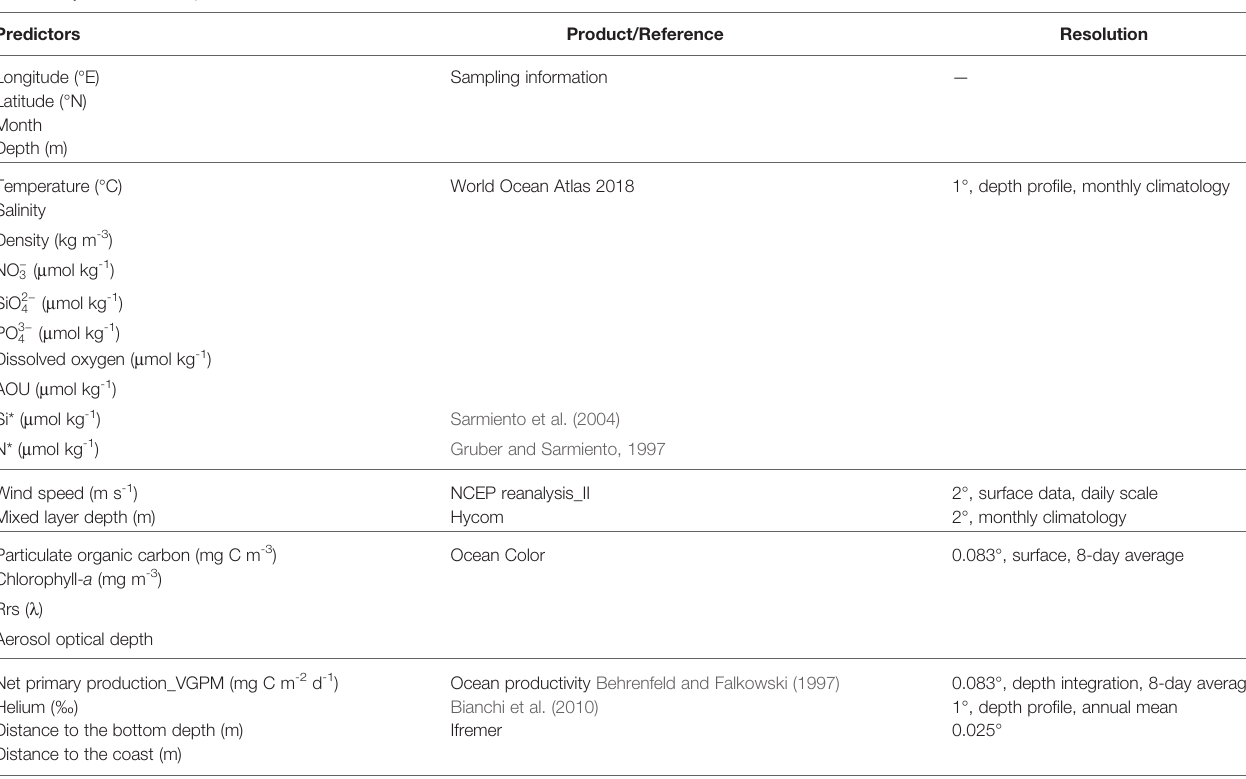
TABLE 1 | Environmental predictors used for the model